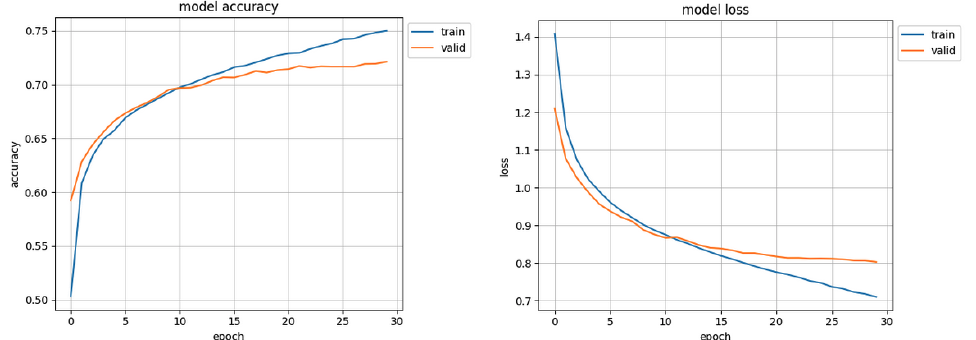
Figure 7. Initial training results, with incorrect validation set.